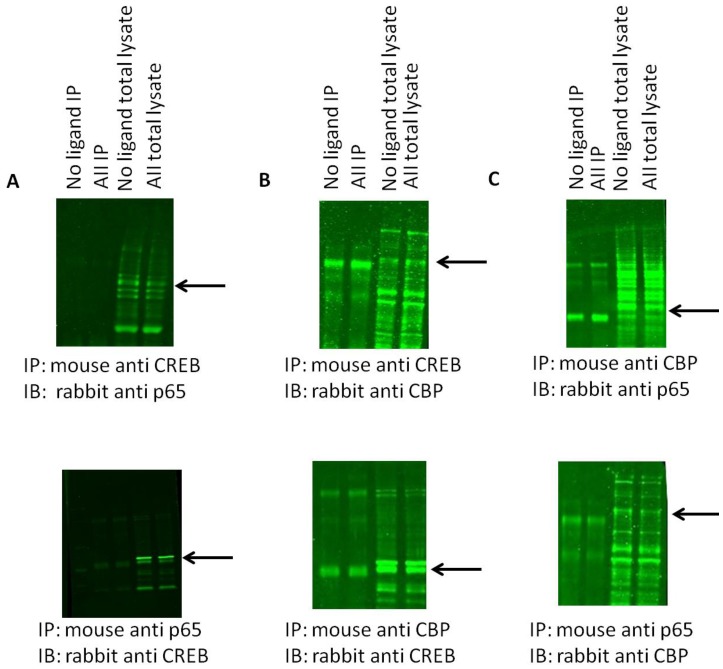
CREB and p65 NF-κB do not physically associate and CBP binds to both CREB and p65 NF-κB.All representative blots are in the following order: Lanes 1–4: immunoprecipitated cell lysate, no ligand, Ang II, Los, Ang II+Los; Lanes 5–8: Total lysate, no ligand, Ang II, Los, Ang II+Los. (A). CREB (C) and p65 NF-κB do not associate. As shown in the first four co-IP lanes, there is no detectable signal but total p65 NF-κB was still detected. (B). CBP and p65 NF-κB physically associate as shown in the first four lanes. (C). CBP and CREB physically associate.